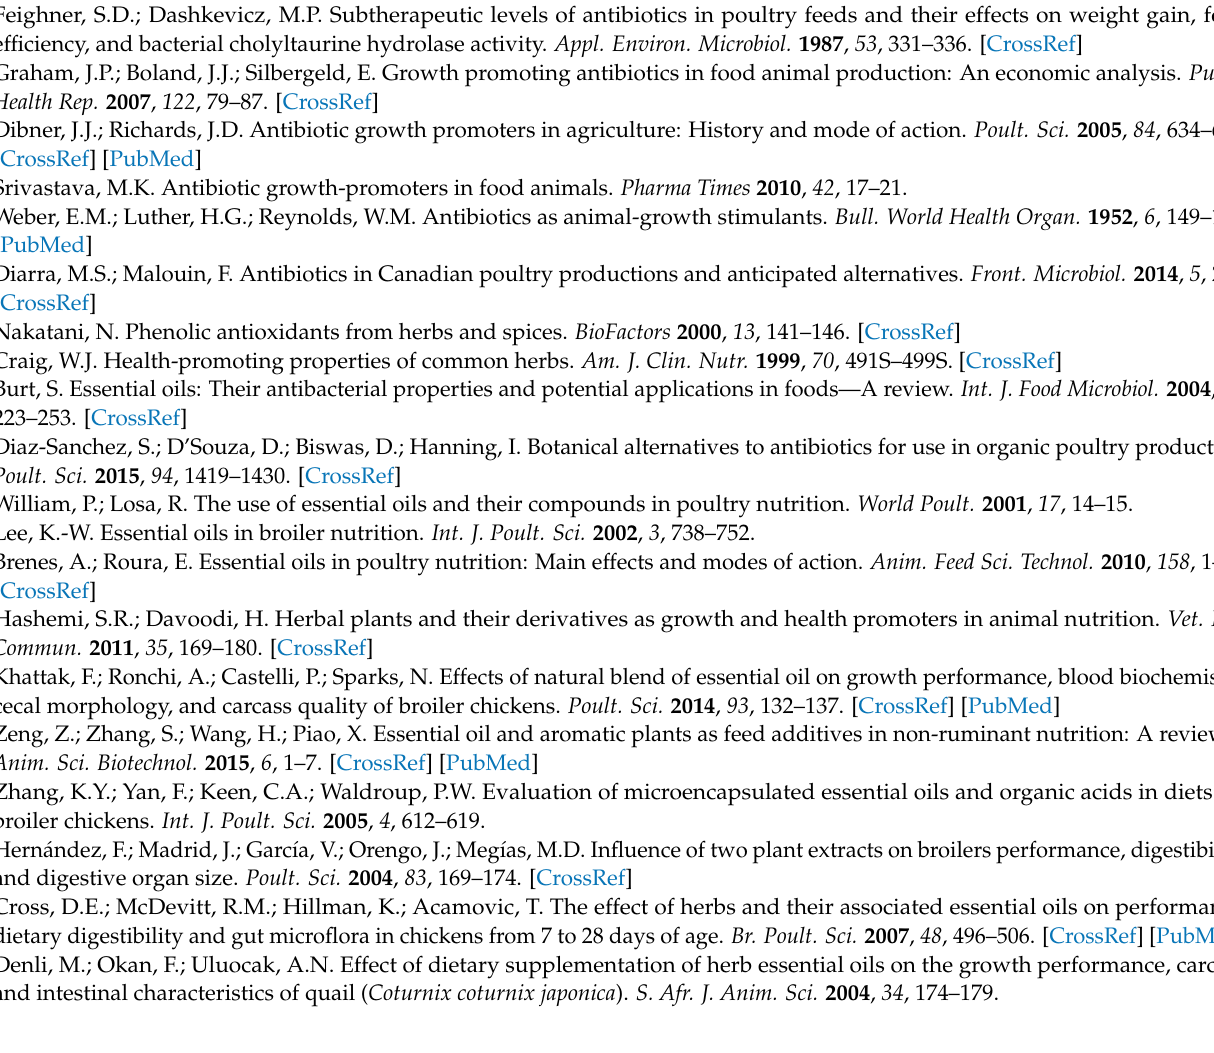
Figure S2: Chromatograms with GC-FID obtain for M. didyma essential oil. Table S1: Composition of Thymus vulgaris L. essential